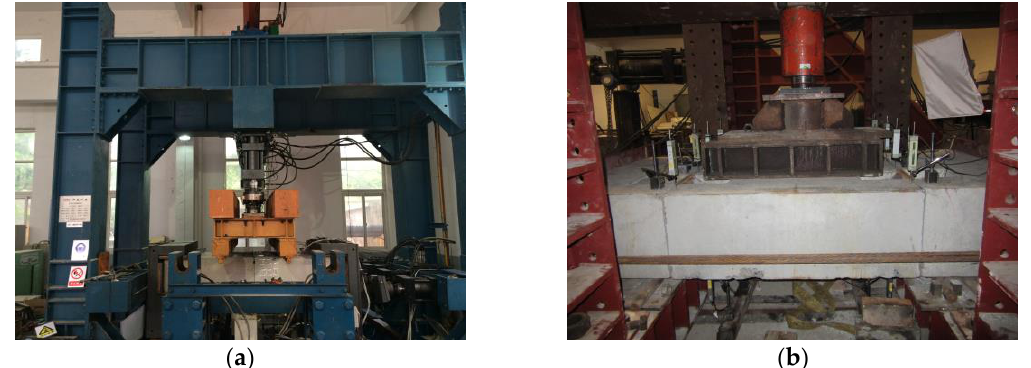
Figure 7. Joint experiments: ( a ) bending moment resistance experiment; ( b ) shear resistance experiment.